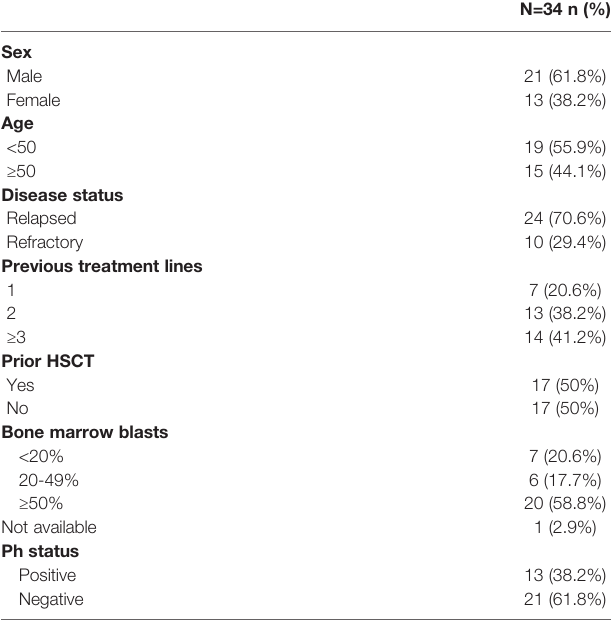
TABLE 1 | Patient